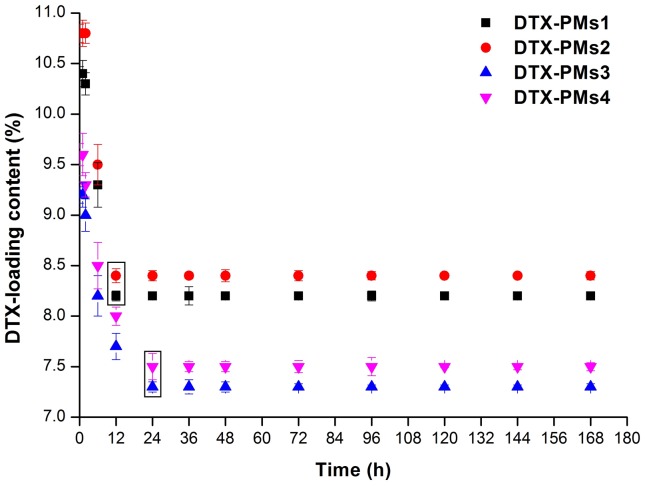
The short-term stability of the DLC of four DTX-PMs stored at room temperature for 7 days.(n = 3).